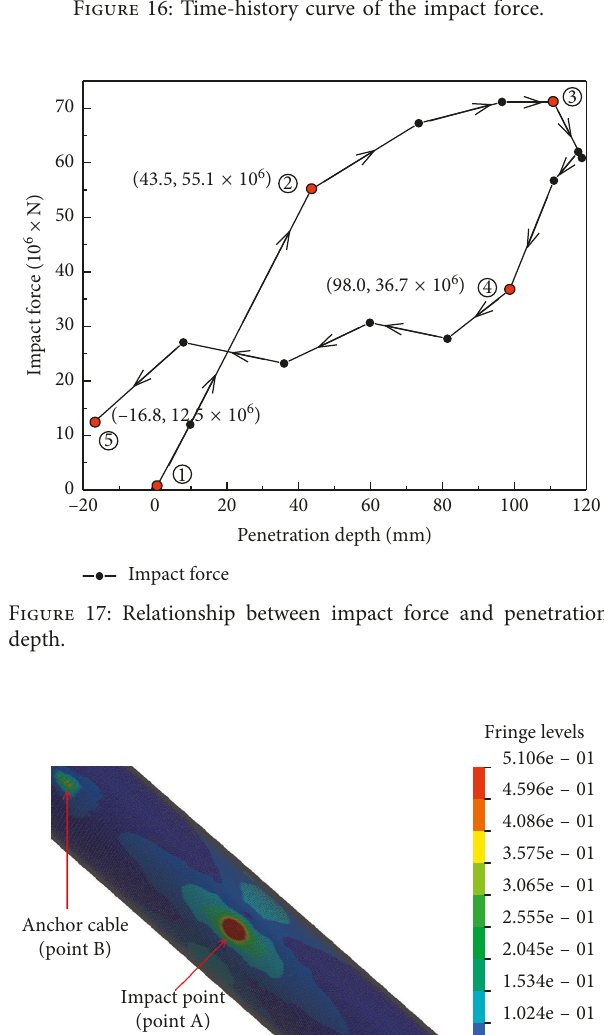
Figure 16: Time-history curve of the impact force.